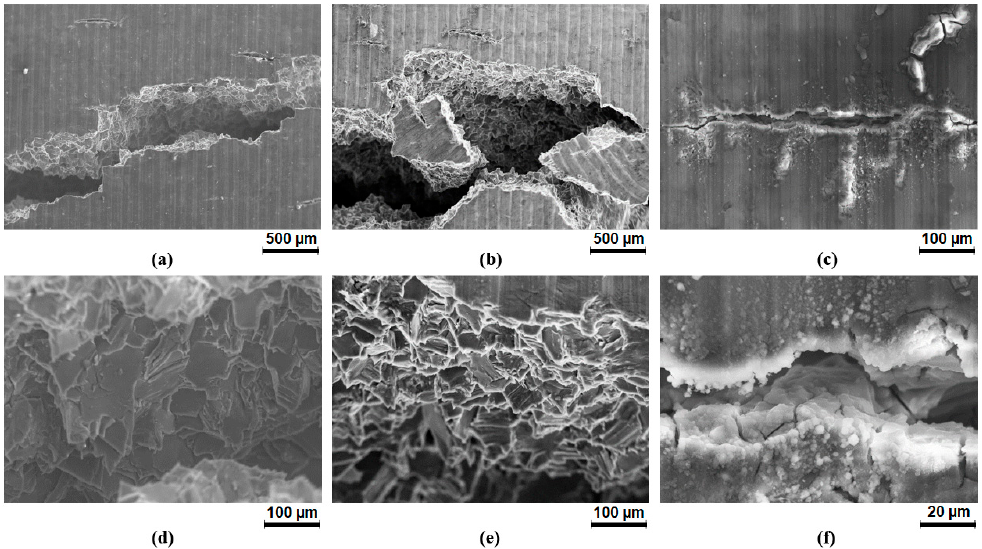
Figure 9. SEM images of the cracked surface of the C-rings after compressive loading in Ringer solution: Mg10Dy1Nd ( a , d ), Mg10Dy ( b , e ) and Mg1Nd alloys ( c , f ).